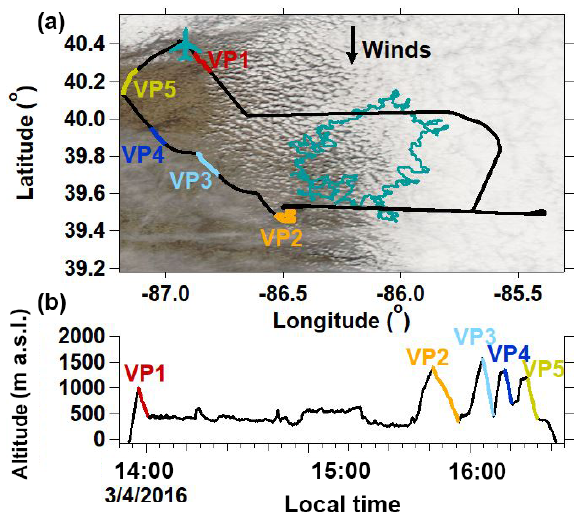
Figure 8. (a) STC flight path overlaying the study site’s cloud cover (https://worldview.earthdata.nasa.gov/, last access: 5 Febru- ary 2018) captured at 12:30LT. The teal outline indicates the Indi- anapolis city boundaries. The West Lafayette, IN, Purdue airport is indicated by the airplane marker. (b) STC case study altitude time series. Colored segments indicate vertical profile (VP)